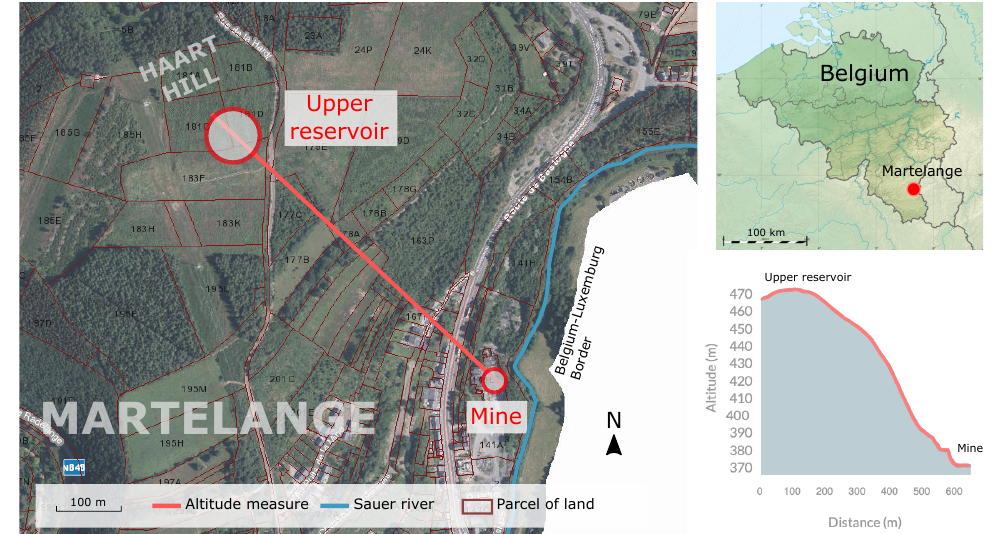
Figure 3. View of Martelange, the mine, and the proposed upper reservoir adapted from